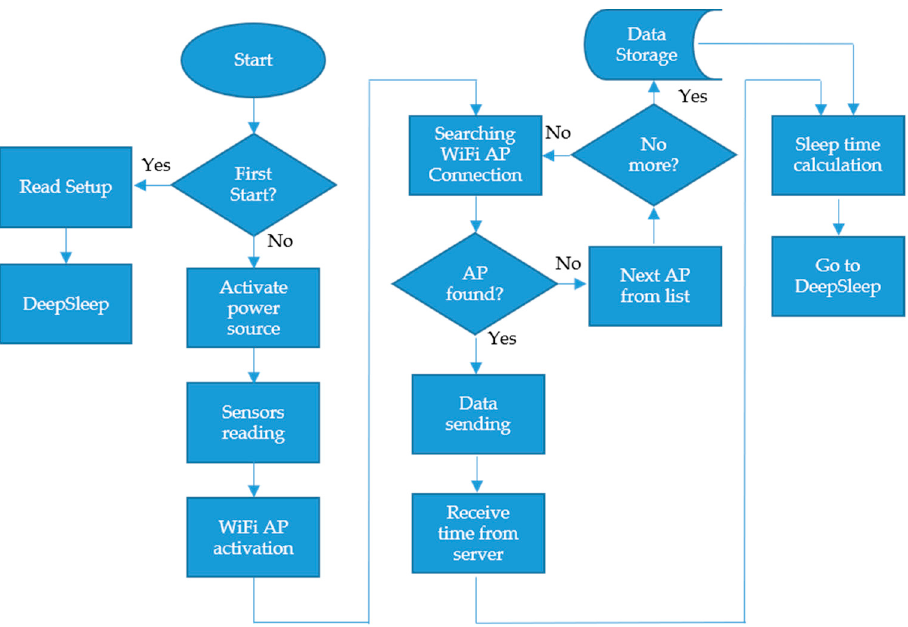
Figure 8. The general operation of the sensor node.